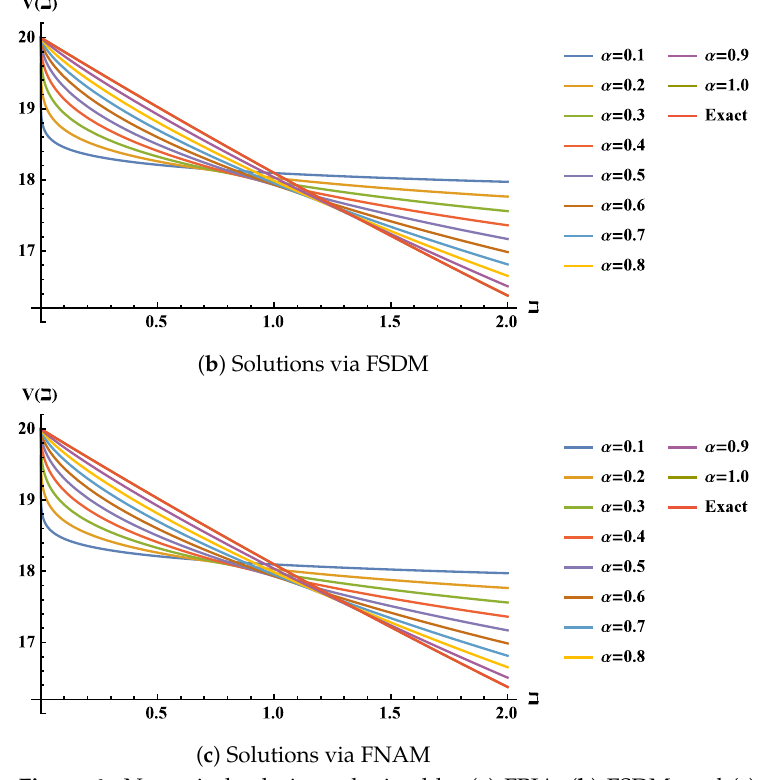
Figure 6. Numerical solutions obtained by ( a ) FPIA, ( b ) FSDM, and ( c ) FNAM of the electrical resistor–capacitor circuit equation of fractional-order at different α